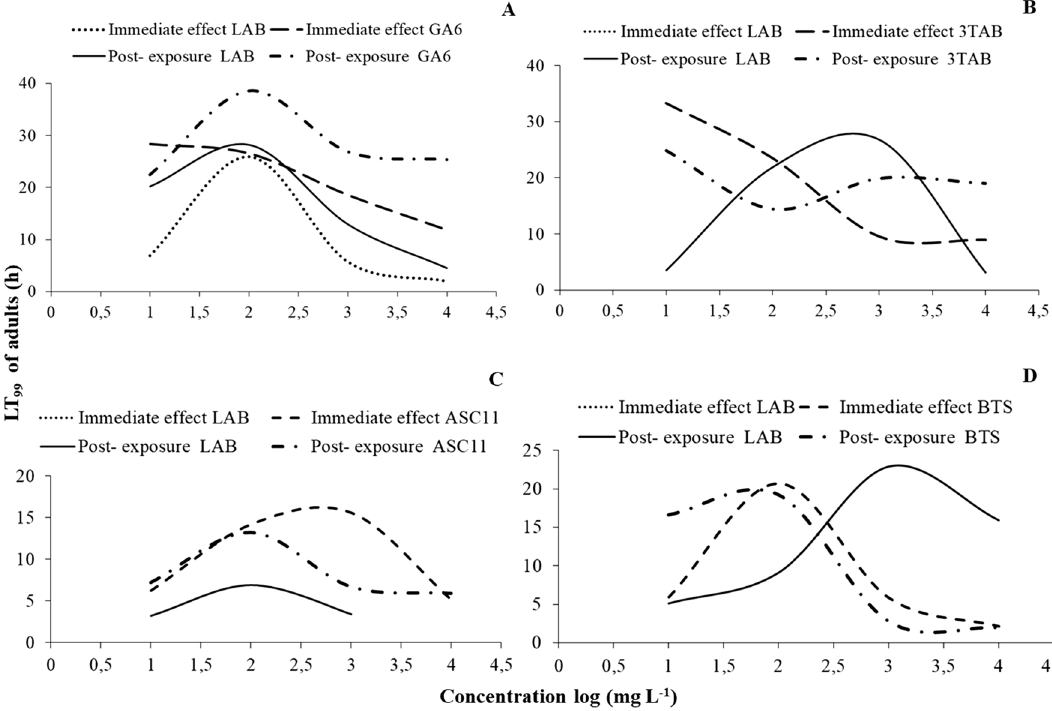
Figure 6. LT 99 of adults of two populations (phosphine-susceptible and –resistant) of R. dominica ( A ), S. oryzae ( B ), O. surinamensis ( C ), T. castaneum ( D ), after exposure to different concentrations of phosphine (immediate effect) and after 7 days (post exposure). Were no lines exist, LT 99 could not be